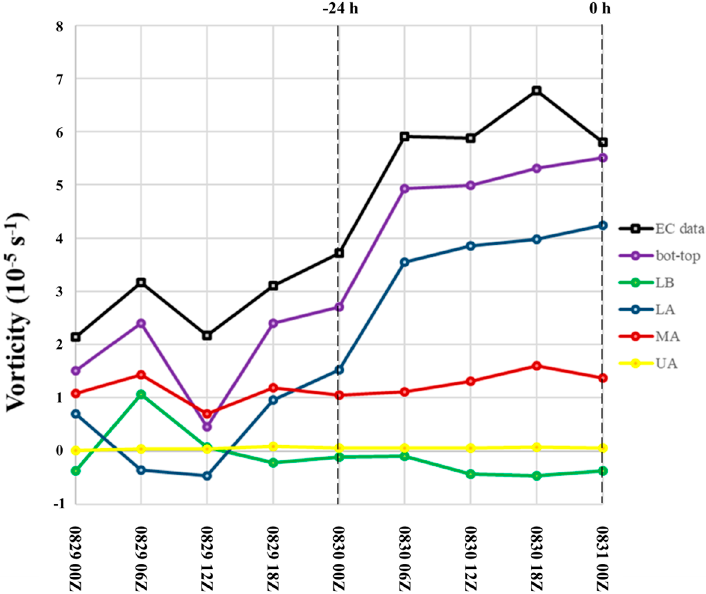
Figure 5. Time series of the area-averaged 850 hPa relative vorticity (averaging over 118 ◦ E to 121 ◦ E, 23.5 ◦ N to 26.5 ◦ N) on ECMWF ERA-Interim data (black line) and those inverted by the PV anomalies of LB (green line), LA (blue line), MA (red line), UA (yellow line) and bot–top (purple line),